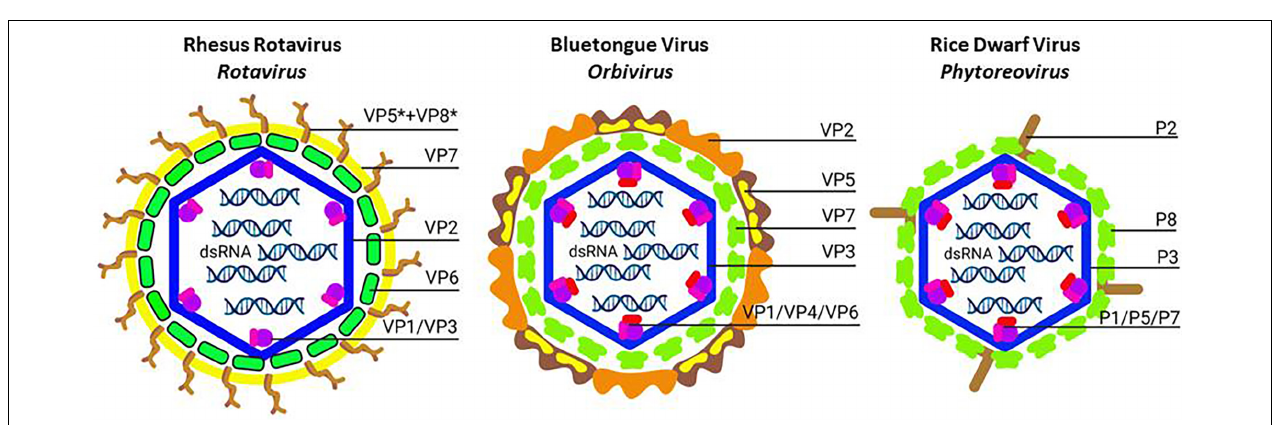
FIGURE 2 | Schematic structure of non-turreted reoviruses ( Sedoreovirinae ): Rhesus rotavirus ( Left ; Rotavirus ), Bluetongue virus ( Middle ; Orbivirus ) and Rice dwarf virus ( Right ; Phytoreovirus ). The transition from triple-layered to double-layered particles is illustrated. In each case, core particles consist of the inner shell (formed by VP2, VP3 or P3; blue) that enclose the dsRNA genome segments together with the T = 13/icosahedral layer of trimers (formed by VP6, VP7 or P6; green). The outer capsid layers of Rhesus rotavirus (processed spike protein VP5* + VP8*; brown, and glycoprotein VP7; yellow) and Bluetongue virus (spike protein VP2; light and dark brown, and penetration protein VP5; yellow) provide the mechanism for entry into mammalian cells. For Rice dwarf virus, the spike protein P2 (brown) is involved in membrane destabilization and is necessary for infection of insect vectors after feeding. It is noted that double-layered core particles of Bluetongue virus and Rice dwarf virus are capable to infect insect cells in culture efficiently. For infection of insect cells, trimers in the T = 13/icosahedral layer (VP7 or P8; green) function as the penetration proteins. Created with BioRender.com.